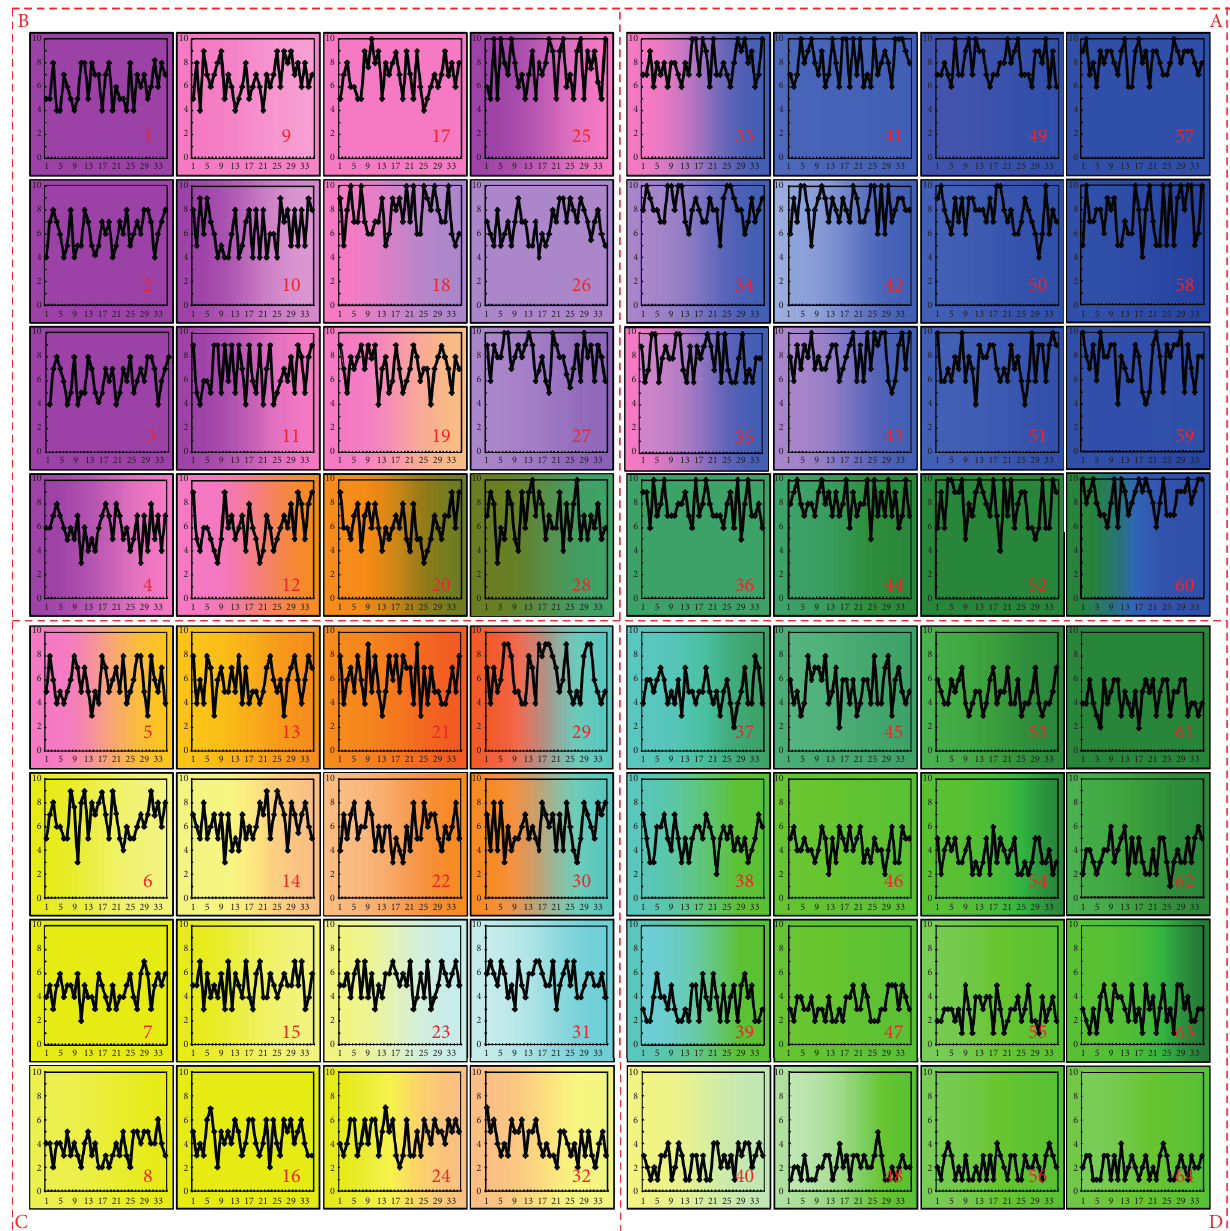
Figure 4: Schematic diagram of 64 traffic state